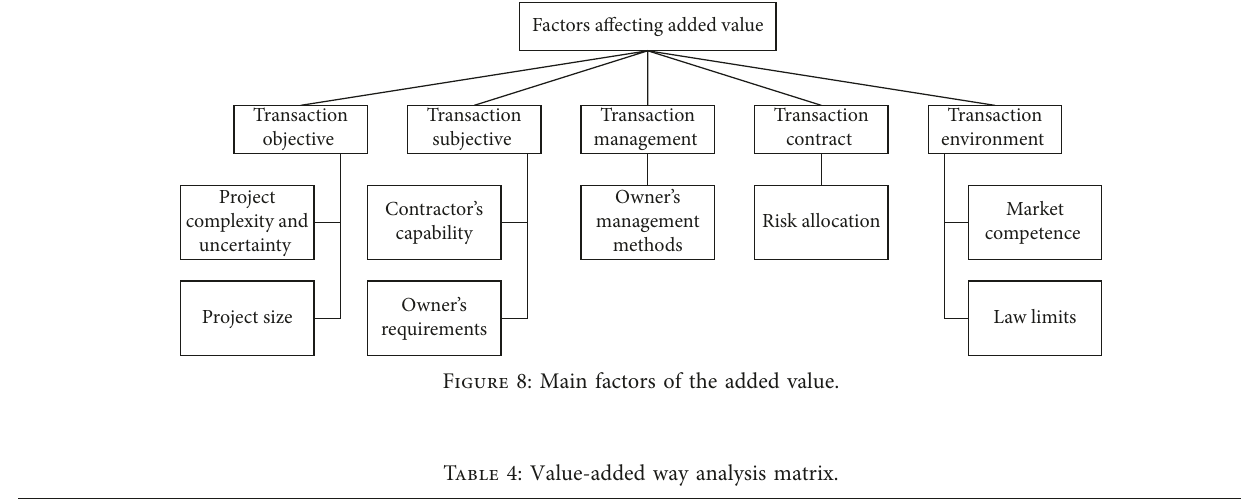
Figure 8: Main factors of the added